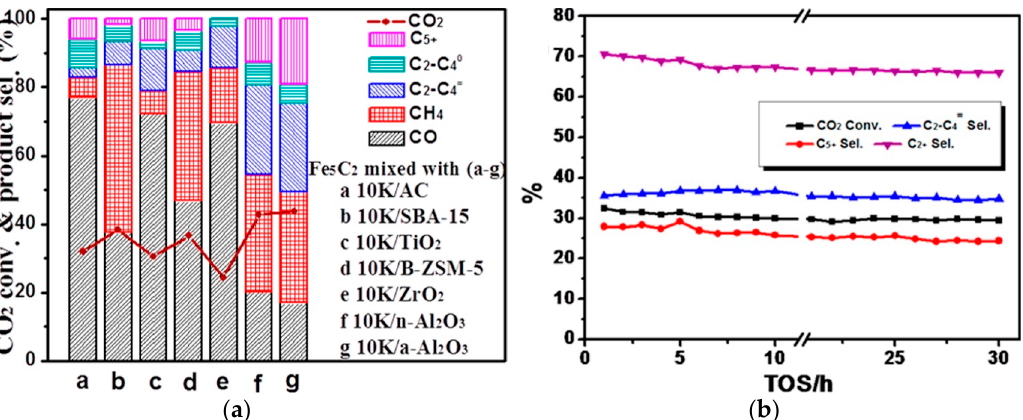
Figure 15. ( a ) Catalytic performance of CO 2 hydrogenation over Fe 5 C 2 -based catalysts on various supports. ( b ) Catalytic performance and stability over an Fe 5 C 2 -10K/a-Al 2 O 3 catalyst (testing conditions: T = 593 K, P = 3.0 MPa, GHSV = 3600 mLg − 1 h − 1 , H 2 /CO 2 molar ratio = 3). Adapted with permission from ref. [15]. Copyright 2018 American Chemical Society.